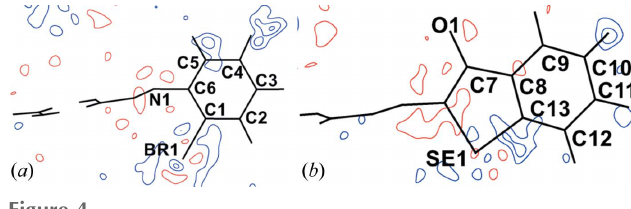
Figure 4 Residual density plots after multipolar refinement, drawn at the 0.1 e A˚ (cid:4) 3 contour level. Positive values are in blue and negative ones in red. Plotted using 9660 reflections [ I > 3 (cid:2) ( I